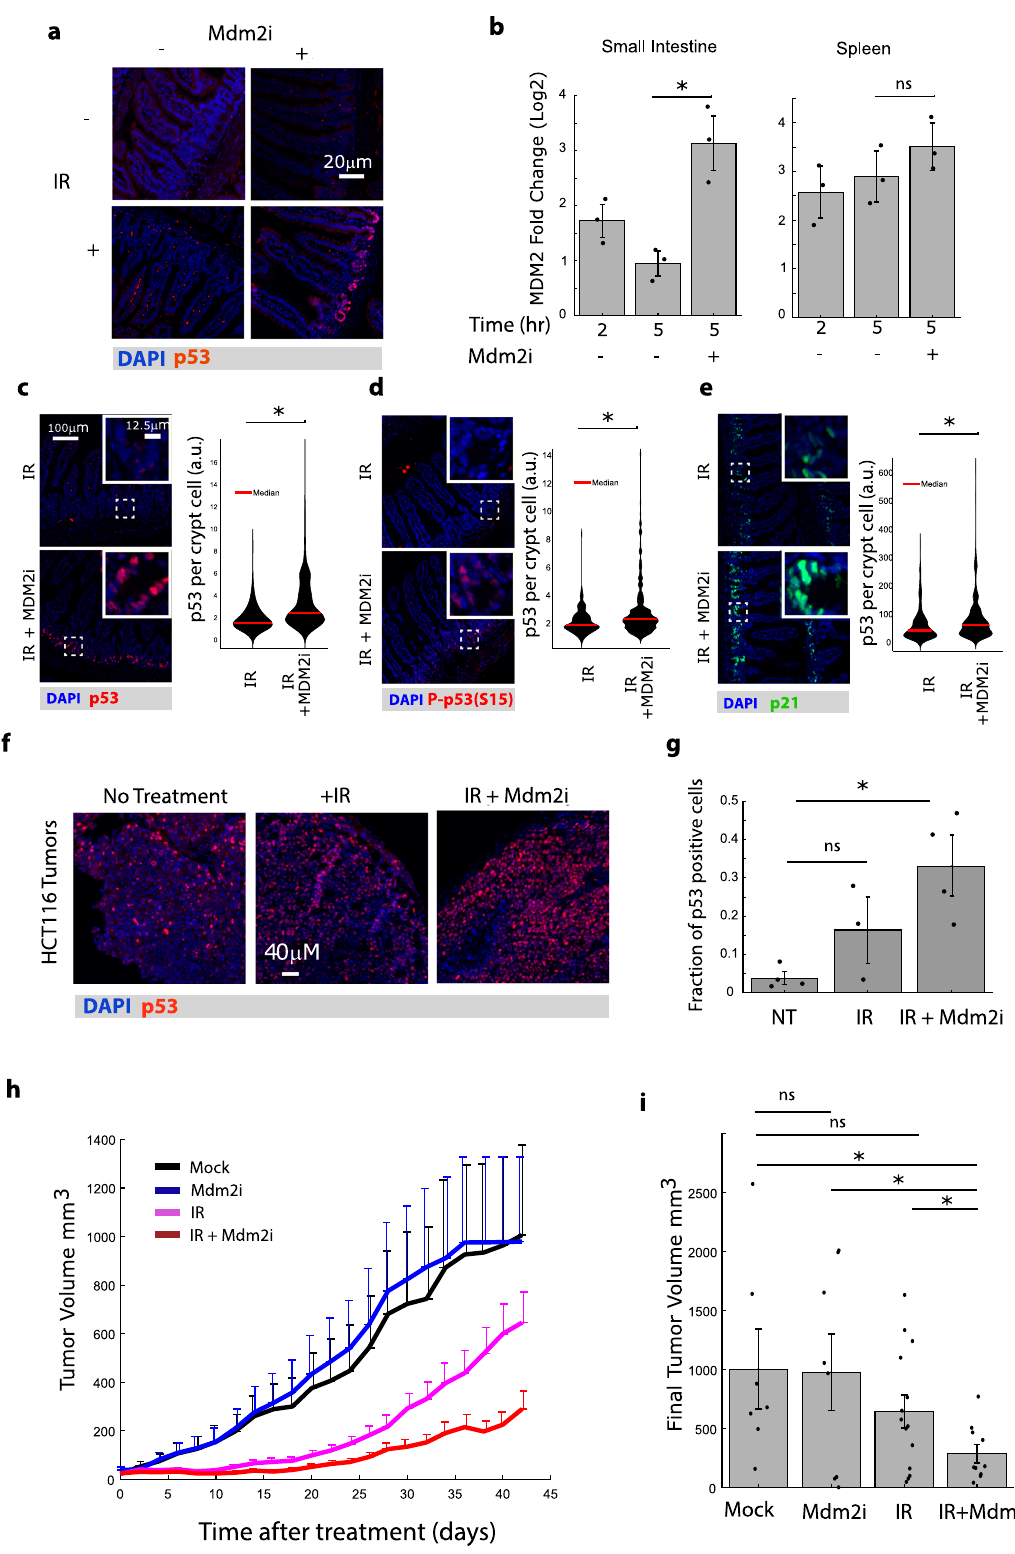
transcriptional activity (as measured by RNA levels of the p53 target gene MDM2) in the small intestine as compared to radiation alone (Fig. 4a, b). On the other hand, in the spleen, in which p53 abundance and activity were naturally sustained over 5 h, the Mdm2i had only a modest effect on p53 transcriptional activity (Fig. 4b). We further examined p53 abundance and